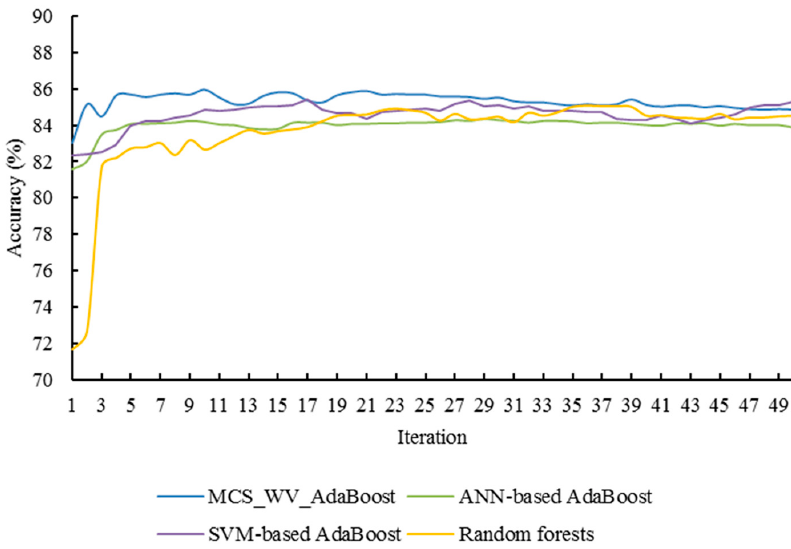
Figure 10. Classification accuracy improvements of MCS_WV_AdaBoost using two base classifier training algorithms: C4.5 and SVM.